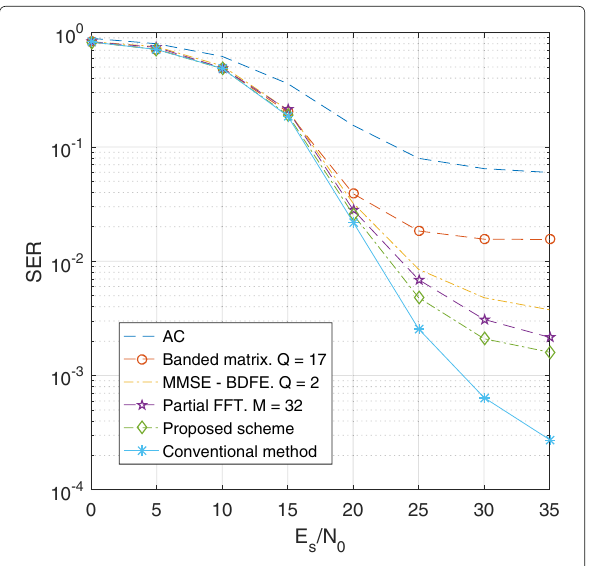
Fig. 2 SER vs. E s / N 0 with f Dmax = 833 Hz Fig. 3 SER vs. E s / N 0 with f Dmax = 1204